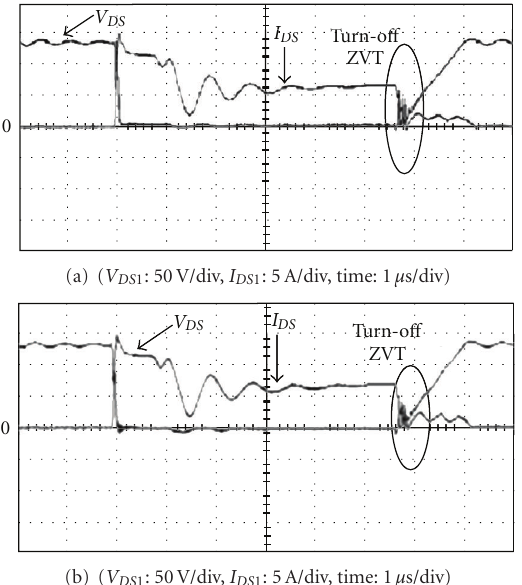
Figure 15: Measured voltage and current waveforms of (a) switch M M 1 , and (b) switch 2 in the proposed converters.